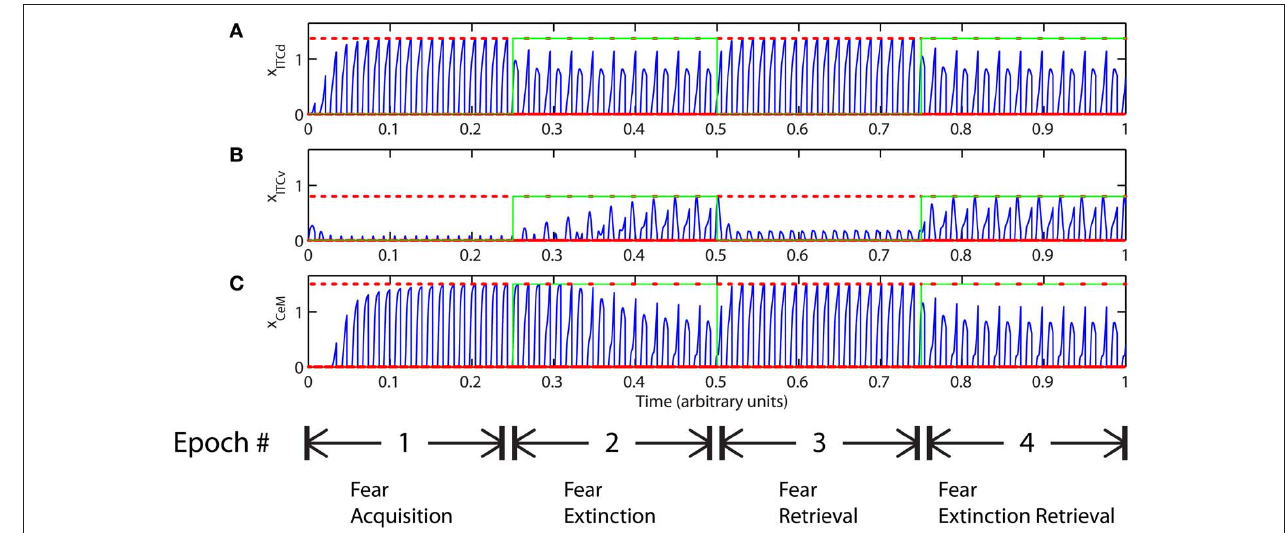
FIGURE 12 | Time evolution of model cell activities during “phobic” mode. Only one of the two overlapping CS signals is extinguished. Each plot (A–C) shows the temporal evolution of a single cell over four consecutive epochs, with the y-axis representing strength of activation. In the first and third epochs, the CS signals, shown in (A) , co-occur with R + ,